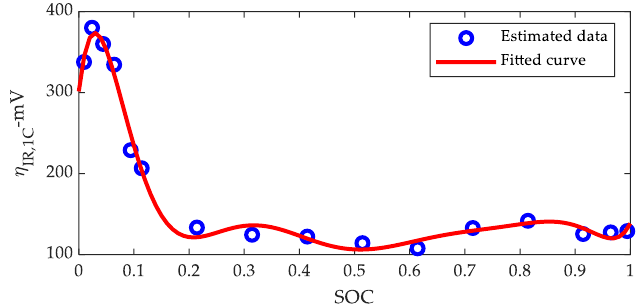
Figure 14. Variation curve of ohmic overpotential at 1 C rate η IR,1C with SOC.